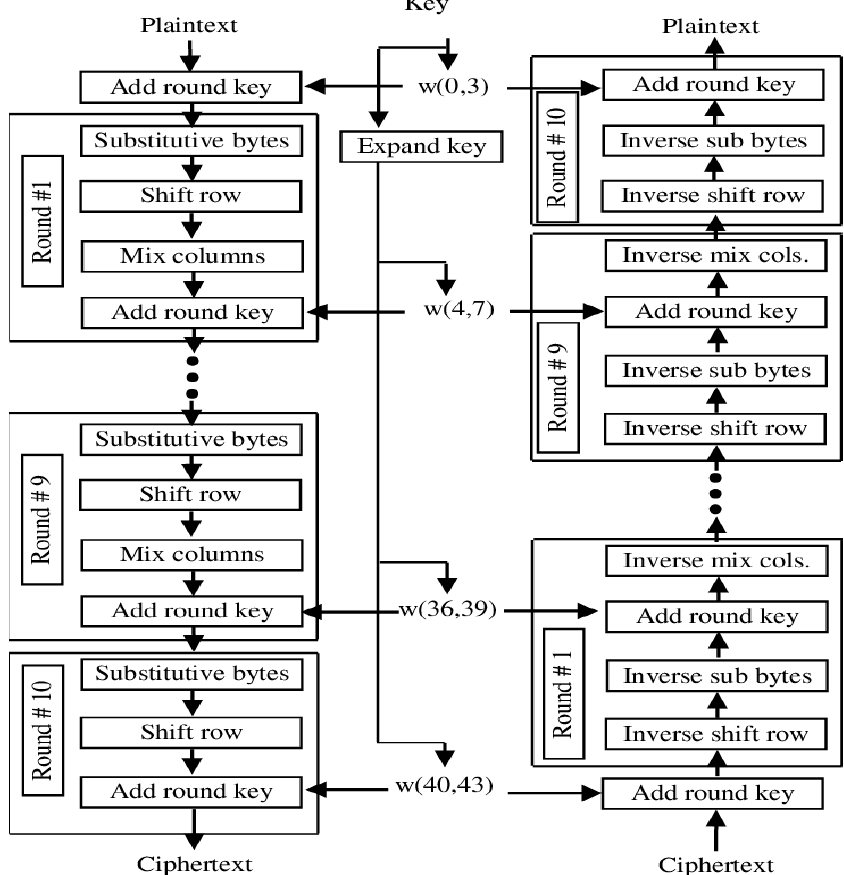
Figure 3. Steps of the Shift Row.